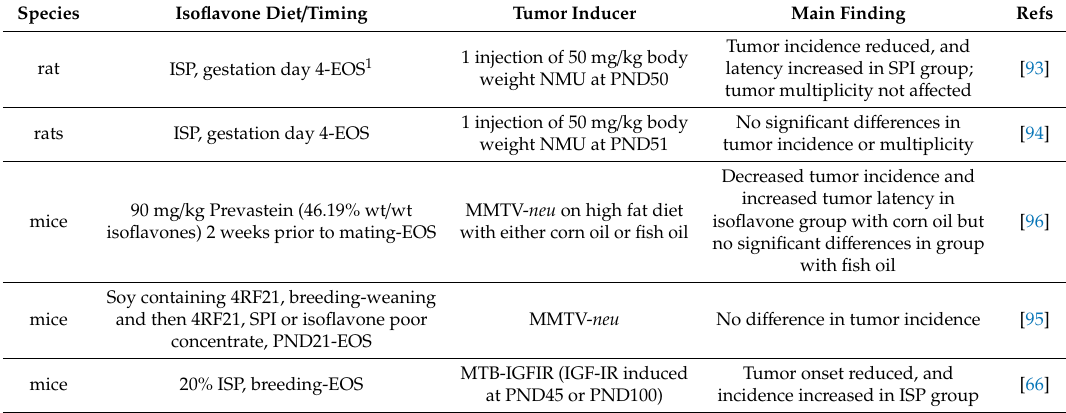
Table 2. Lifetime Soy / Isoflavone